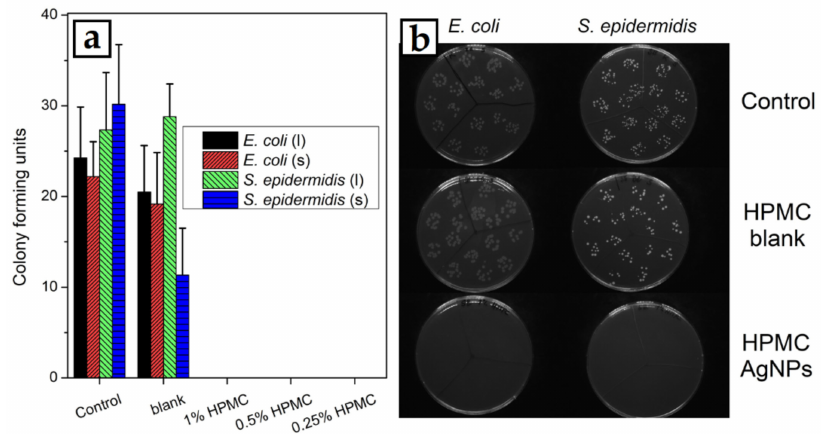
Figure 12. ( a ) Results of the antibacterial activity tests of the HPMC–AgNP colloids (columns marked l) and spin-coated thin films of HPMC–AgNP composites (columns marked s) against E. coli and S. epidermidis bacterial cells. ( b ) Images of Petri dishes after bacterial cultivation in contact with